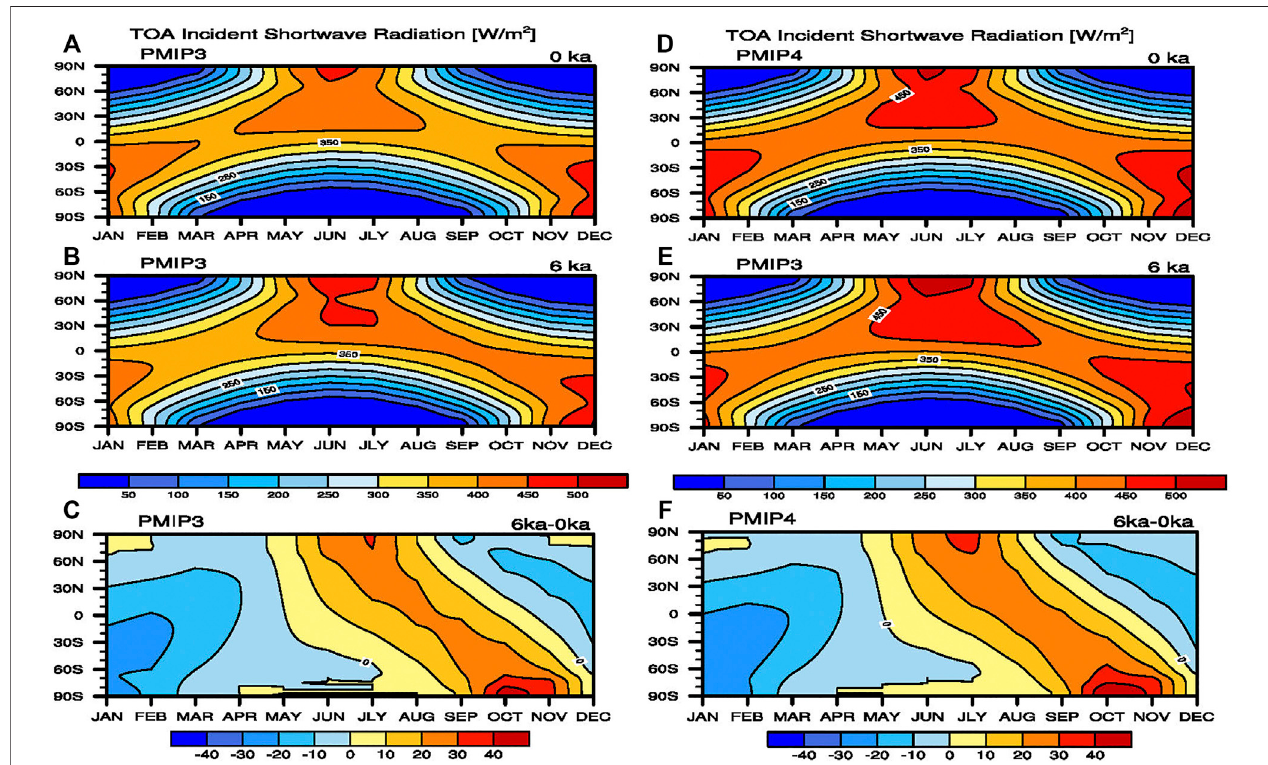
FIGURE 5 | MME of mean insolation at the top of the atmosphere over the tropical Paci fi c (averaged between 120 o E and 160 o E) from PMIP3 (left column) and PMIP4 (right column) models. (A) and (D) are PI simulations; (C) and (B) are MH simulations; and (C) and (E) are their difference (MH minus PI).